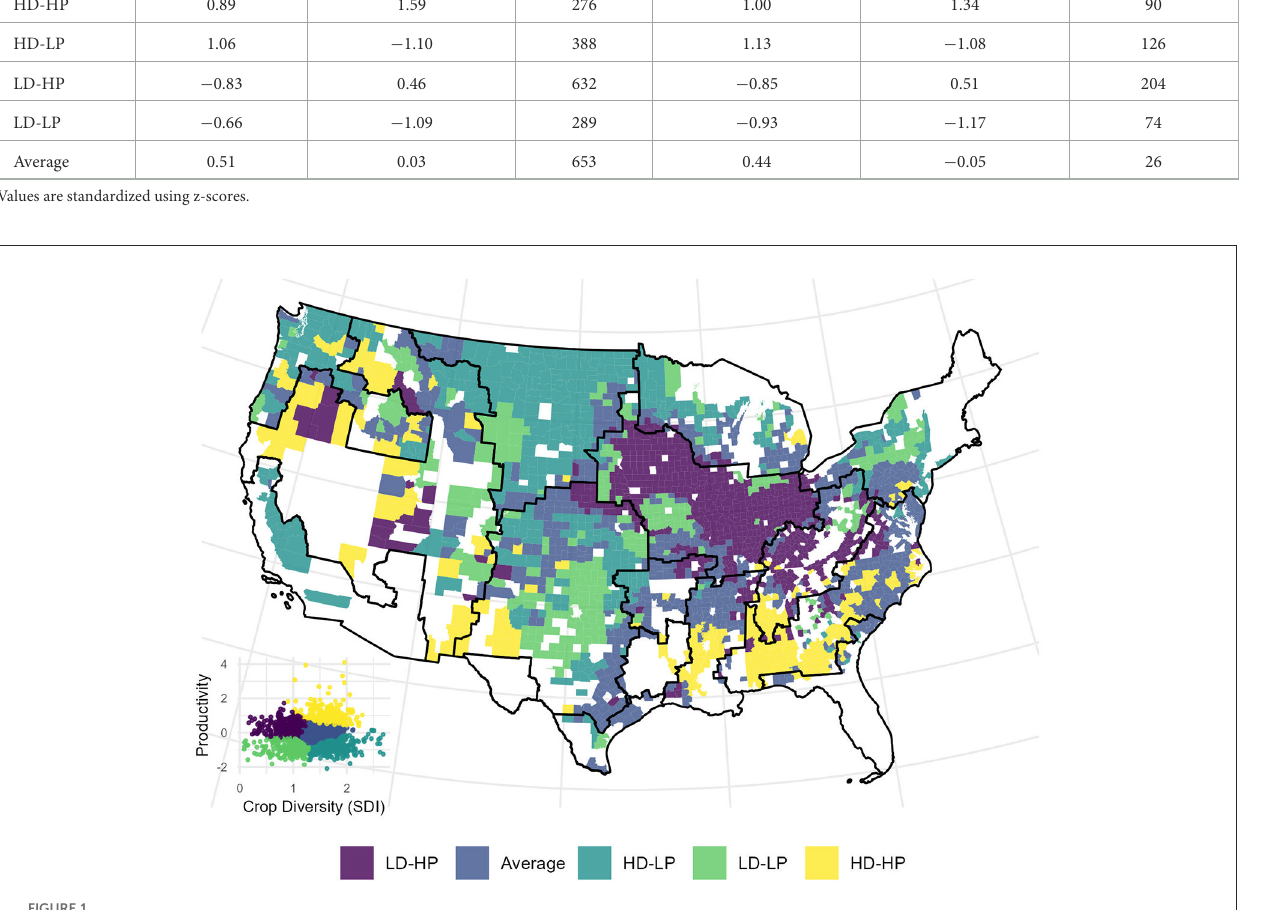
county classification is ∼ 88% with more balanced class-specific classification accuracy where the balanced accuracy is 97% for LD- HP counties and 86% for HD-HP counties. Despite the removal of counties with overlapping diversity or productivity characteristics in the archetypal county analyses, clear spatial patterns in classification accuracy are still observed (Supplementary Figure